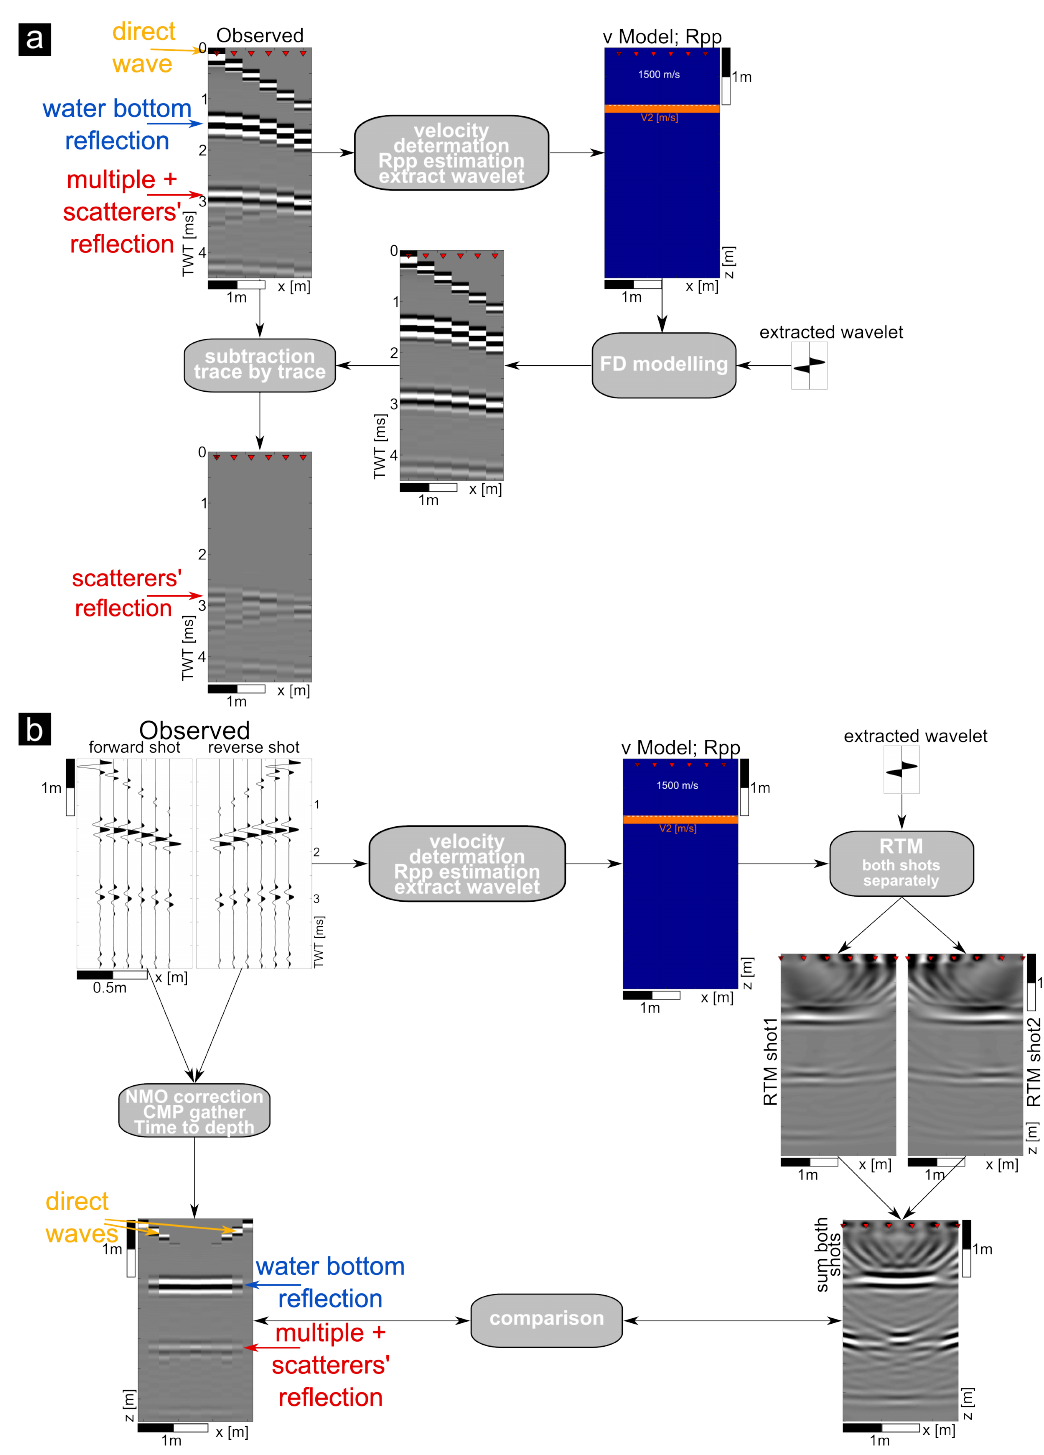
Figure 2. Illustration of the processing steps applied in the tested multiple suppression approaches. Panel ( a ) shows the basic processing steps of the “Prediction and Subtraction” approach for a multi-offset example. Panel ( b ) illustrates of the processing steps applied in the “RTM-Deco” approach for a multi-offset example (own configuration). In the case of data from the multi-offset configuration, the shots from the left and right source were migrated separately with the 1D imaging condition and then both migrated images are summed to obtain the resulting image (Figure 2b). In the case of constant-offset data, each shot was also migrated separately, and the resulting image was obtained